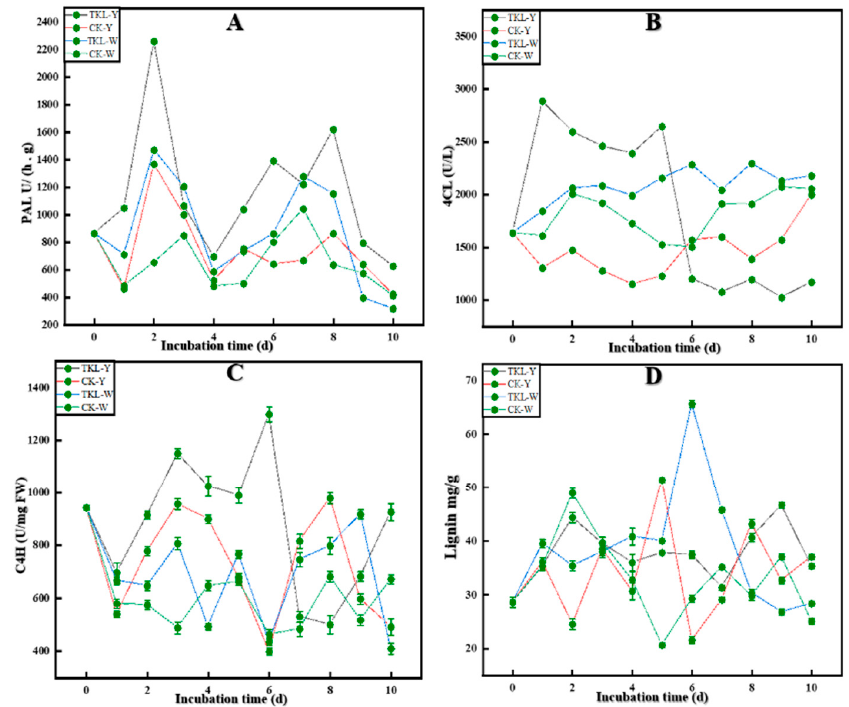
Figure 8. PAL changes of okra in four groups at 28 ◦ C for 0–10 days ( A ), 4CL changes of okra in four groups ( B ), C4H changes of okra in four groups ( C ), and okra lignin content changes in four groups ( D ).